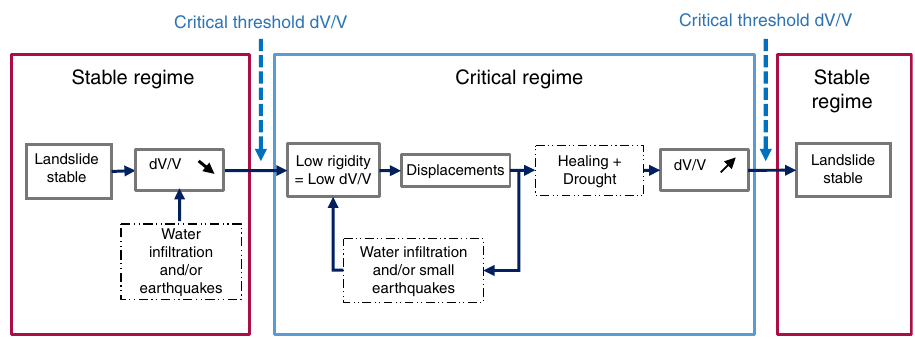
Fig. 5 Schematic representation of the different forcings affecting the slow-moving